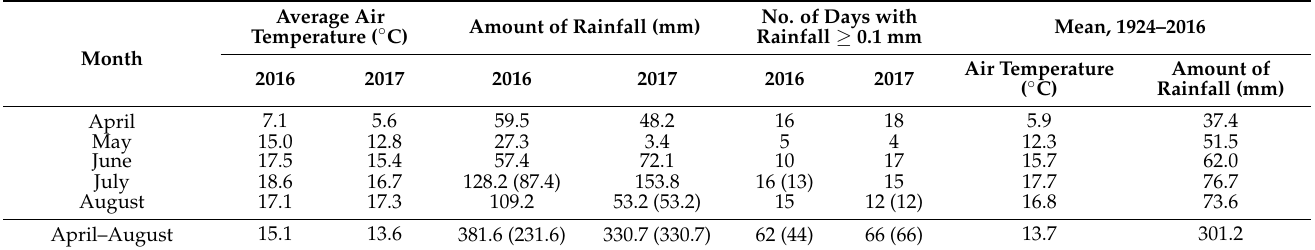
Table 5. Meteorological observations for the growing seasons of 2016 and 2017 in